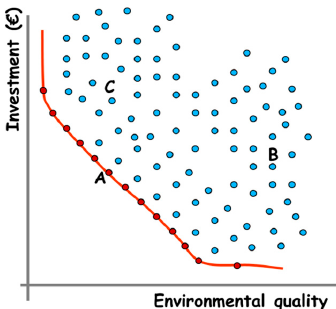
Figure 5. Conceptual illustration (with two objectives) of Pareto optimal solutions ( red ) and non ‐ efficient ( blue ) strategies according to environmental impact and investment criteria. Each point represents the results of an IWMP evaluation for a different PoM strategy. Each solution in the Pareto set is said to be non ‐ dominated by any other solution. Instead, the blue solutions in the figure are worse (dominated) as regards both criteria, for at least one of the non ‐ dominated set. From the point of view of a decision maker it does not have any sense to select the solutions B or C in the Figure 4 since, for example, point A is better in terms of the considered objectives. The shape of the Pareto frontier depends on whether the different objectives are to be maximized of minimized.